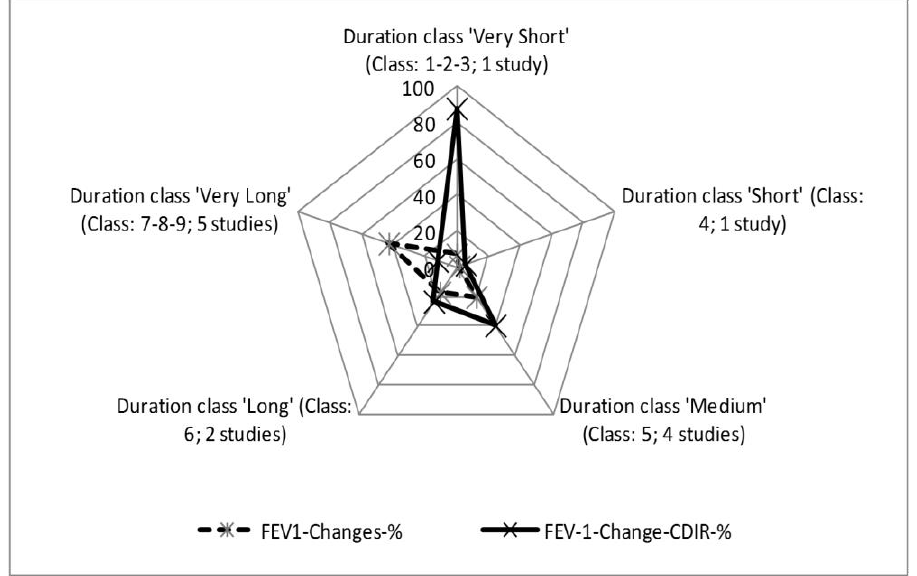
Figure 2. Positioning CTSs by considering Duration classes (Values standardized by considering the maximum FEV1 Change (26.15%) and FEV1 Change CDIR (0.526%). Average values calculated by duration classes, “Very short”, Short,